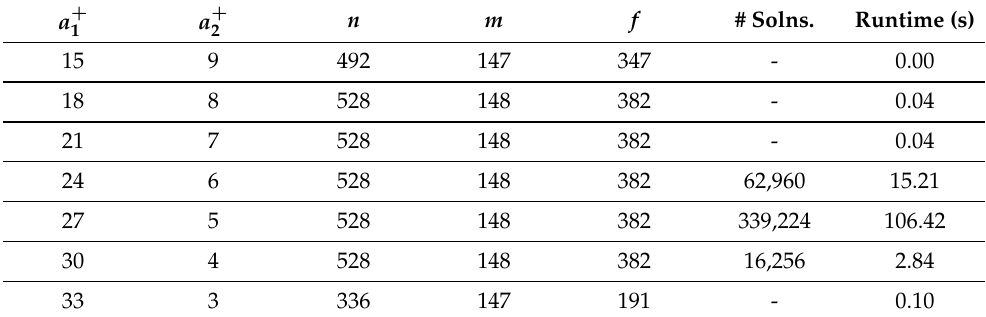
Table 3. Number of tiling solutions (# solns.) and runtimes in seconds for CPLEX to solve the seven pariomino tiling subproblems in Example